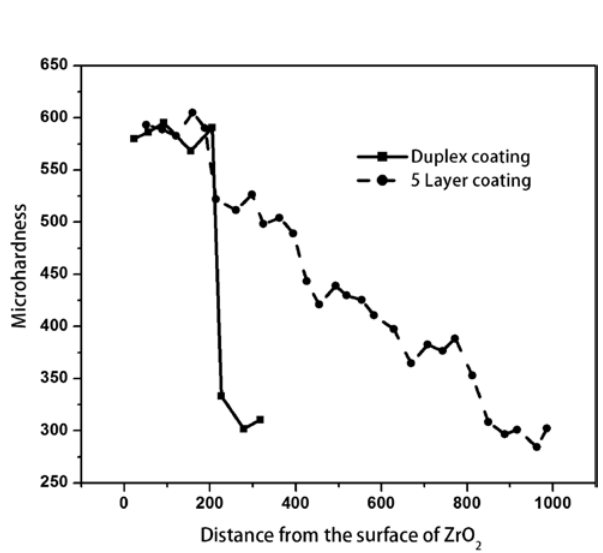
Figure 26: Variations of microhardness in coating